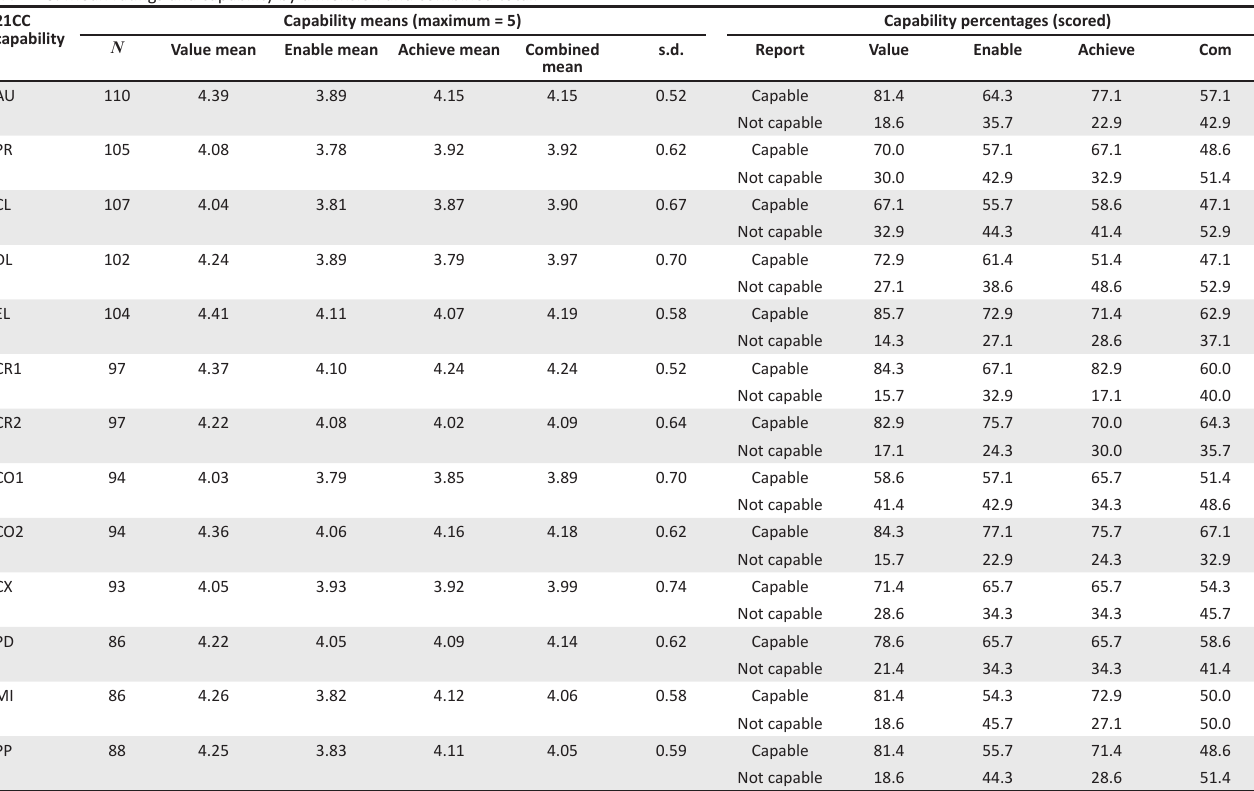
TABLE 6: Mean ratings and capability by dimension and combined total. 21CC